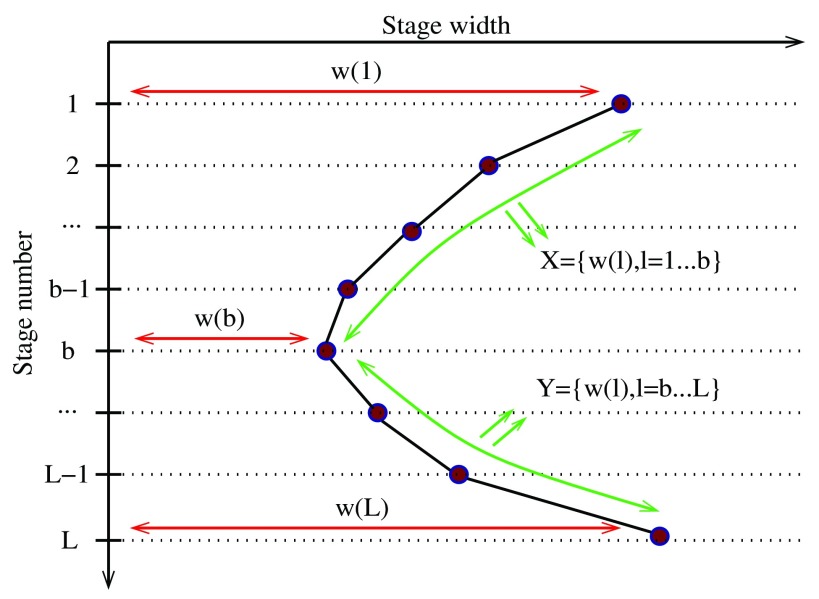
Illustration of the
H score calculation.Let
w(
l) be the width of stage
l. Let
w
b be the minimum width across all stages, and suppose that this minimum occurs at stage
l =
b; this is the
waist of the network (ties are broken so that the waist is closer to ⎣
L/2⎦). Consider the sequence
X = {
w(
l)},
l = 1, . . .
b} and the sequence
Y = {
w(
l)},
l =
b, . . .
L}. We denote the normalized univariate Mann-Kendall statistic for monotonic trend on the sequences
X and
Y as
τ
X and
τ
Y, respectively. The Mann-Kendall statistic varies between -1 (decreasing) and 1 (increasing), and it is approximately zero for a random sequence. We define
H = (
τ
Y −
τ
X)
/2;
H is referred to as the hourglass score.
H = 1 if the DGEN is structured as an hourglass, with a decreasing sequence of
b stages followed by an increasing sequence of
L −
b stages. In the computational modeling results, we do not consider the width of the first stage because it can never decrease in Models-1,2,3. We also define a variation of the hourglass score in which we do not take into account adjacent stages in calculating the two Mann-Kendall statistics. That statistic is denoted by
H~ and is referred to as the robust hourglass score.